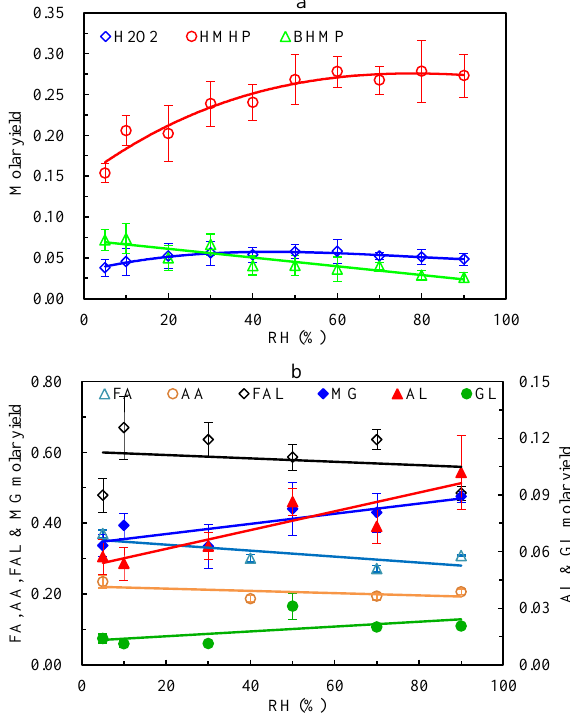
Fig. 3. Dependence of the product yields for (a) peroxides and (b) carbonyls and acids on relative humidity (RH). FA: formic acid; AA: acetic acid; FAL: formaldehyde; MG: methyl glyoxal; AL: ac- etaldehyde; GL: